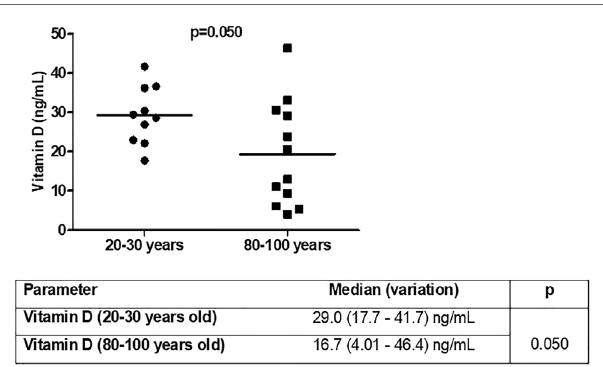
FigUre 7 | Vitamin D [25(OH)D3] levels in young ( n = 10; 20–30 years) and old ( n = 12; 80–100 years) individuals.